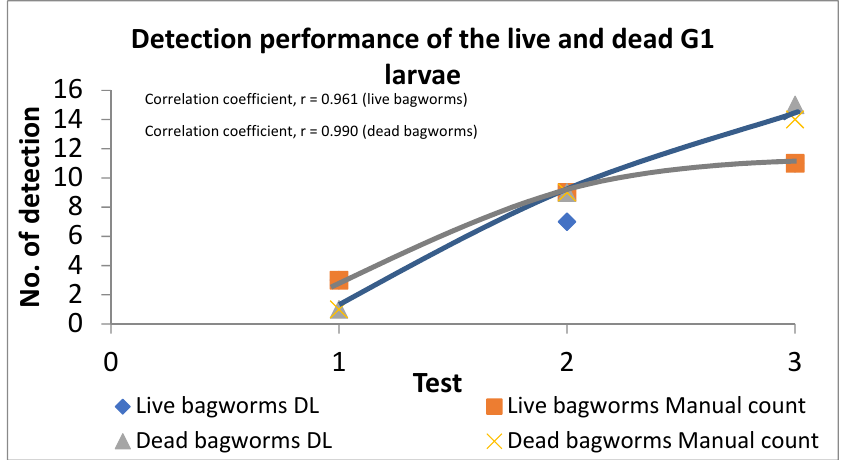
Figure 16. Detection performance of the live and dead G1 larvae by deep learning (DL) and manual counting.